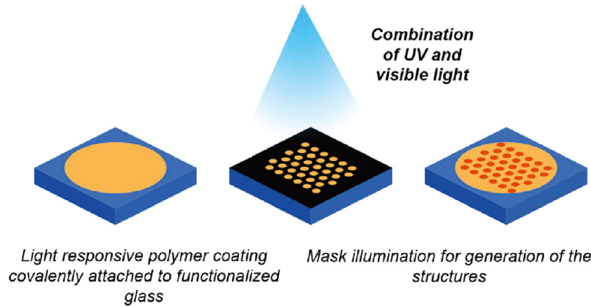
Figure 14: Light - responsive polymer was coated on glass substrate and hierarchically structures were generated by mask illumination ( reproduced from ref. [ 104 ]) .